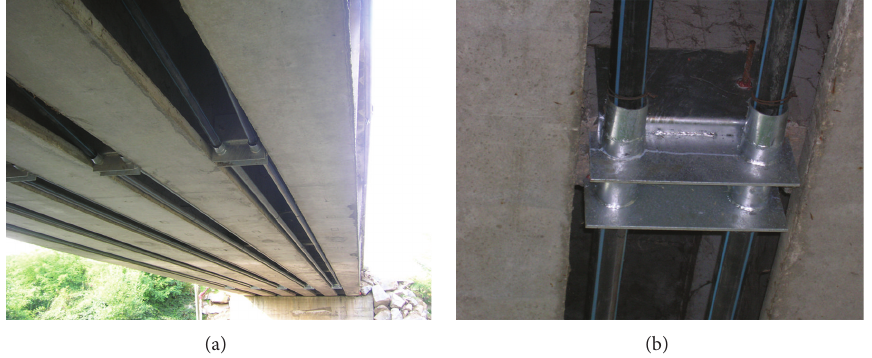
Figure 5: (a) View of external prestressing; (b) metallic saddle of deviation.